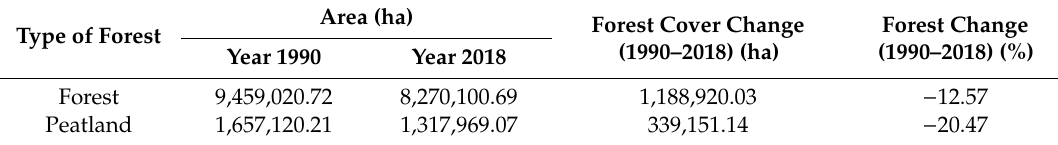
Table 5. Amount of forest cover in Sarawak (1990 and 2018).